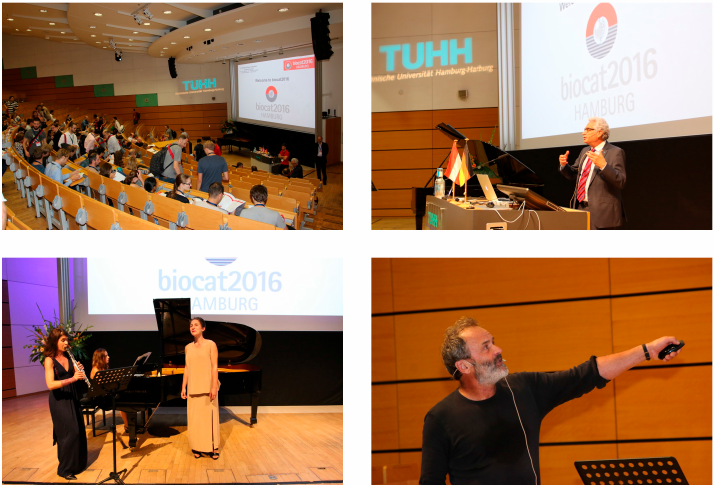
Figure 2. Biocat2016 opening ceremony. Top left: Audience. Top right: Congress chair Garabed Antranikian welcomes the participants. Bottom left: Musicians. Bottom right: Kurt Faber gives the prestigious opening lecture.